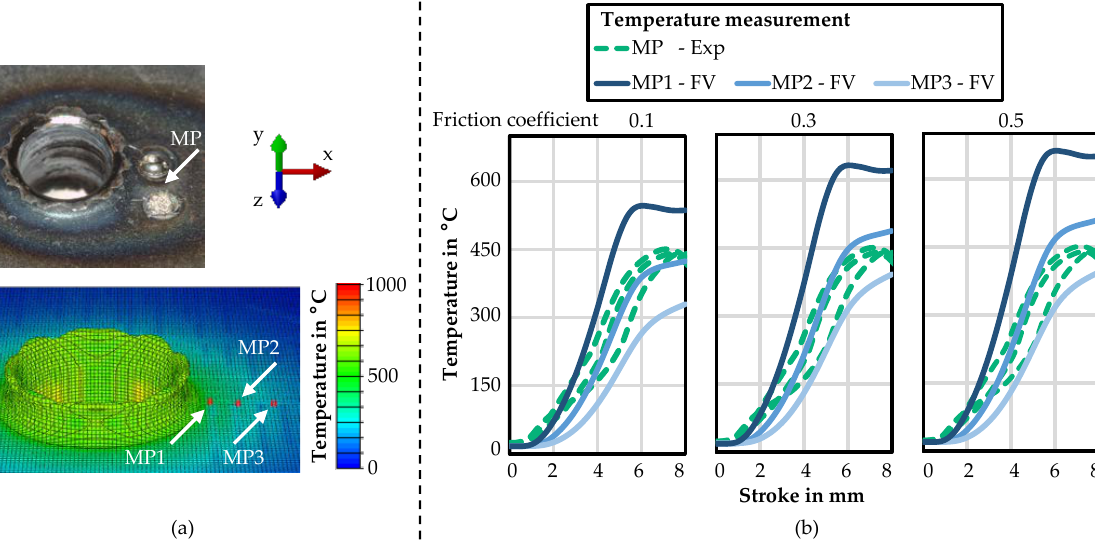
Figure 13. Temperature-measuring position in the experiments and in the FV simulation ( a ); and experimental measured and simulated temperature–stroke curves ( b ) for friction drilling HX220.